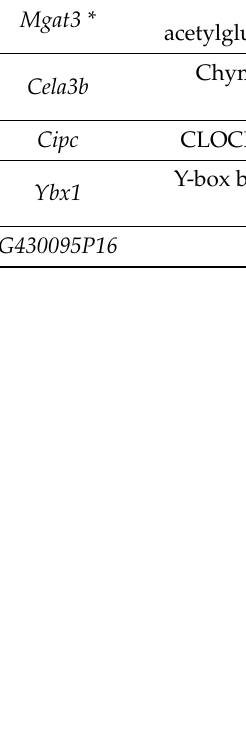
Table 8. Fold change values of the upregulated PC-related genes with respect to the sham group (excluding EDPC-related genes).